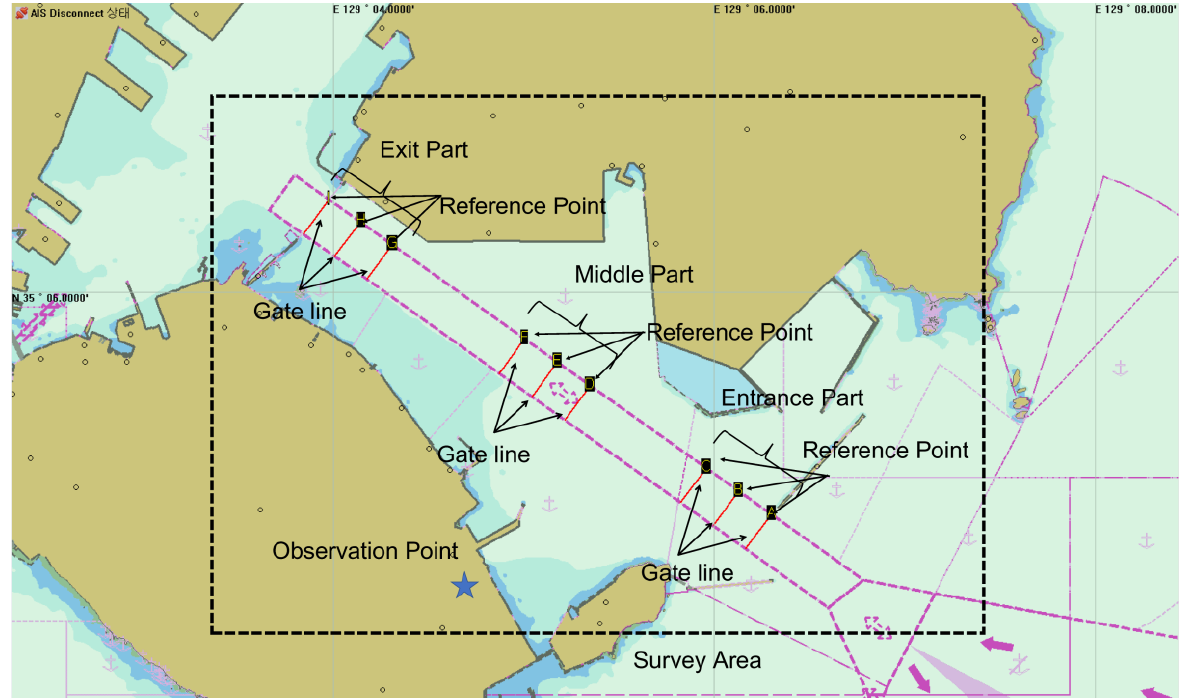
Figure 6. Gate line of Busan North Port.